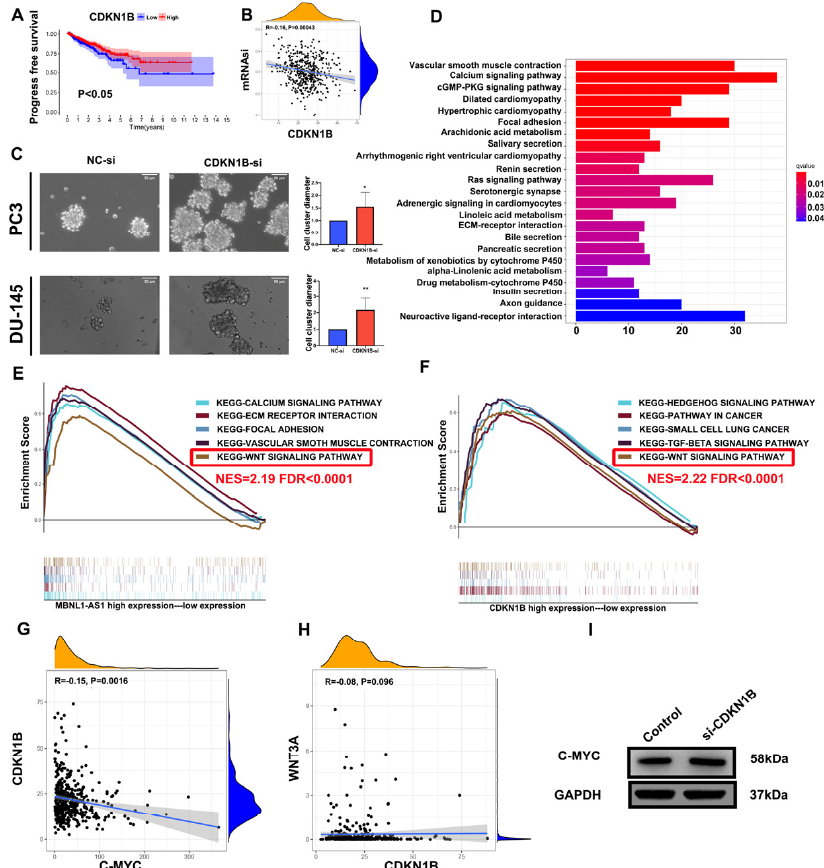
Figure 6. MBNL1-AS1 mediates the Wnt pathway through the miR-221-3p/CDKN1B/C - myc axis. ( A ) The KM analysis of CDKN1B. ( B ) The correlation analysis of mRNAsi and CDKN1B. ( C ) The sphere formation assay was used to examine the effect of CDKN1B knockdown on PCSC function. ( D – F ) The GO and KEGG analyses were used to identify the potential function of MBNL1-AS1. GSEA was used to detect the overlapping signaling pathways between MBNL1-AS1 and CDKN1B. ( G , H ) Correlation analysis was used to identify the relationship between CDKN1B, C-myc and WNT3A. ( I ) Western blot analysis was used to detect the corresponding protein expression levels in PC3-CSCs. * p -value < 0.05; ** p -value < 0.01.